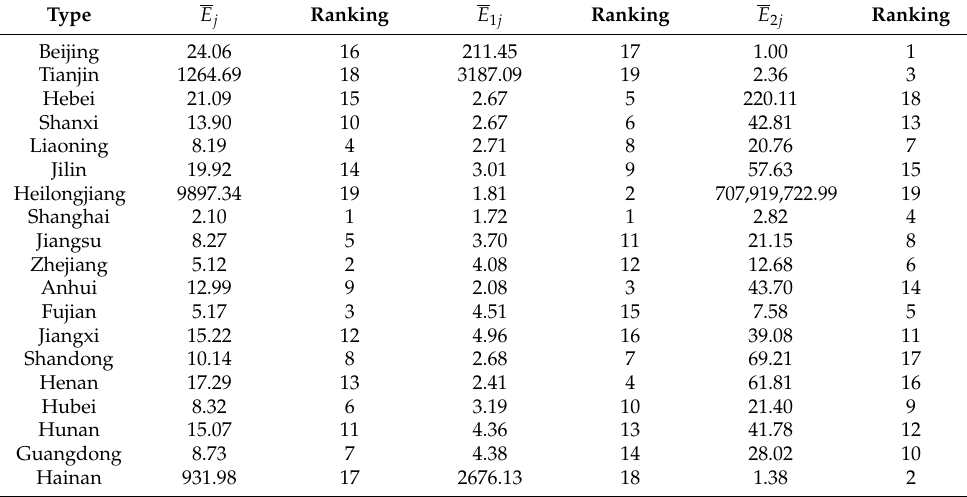
Table 4. WEF-Eco system efficiency